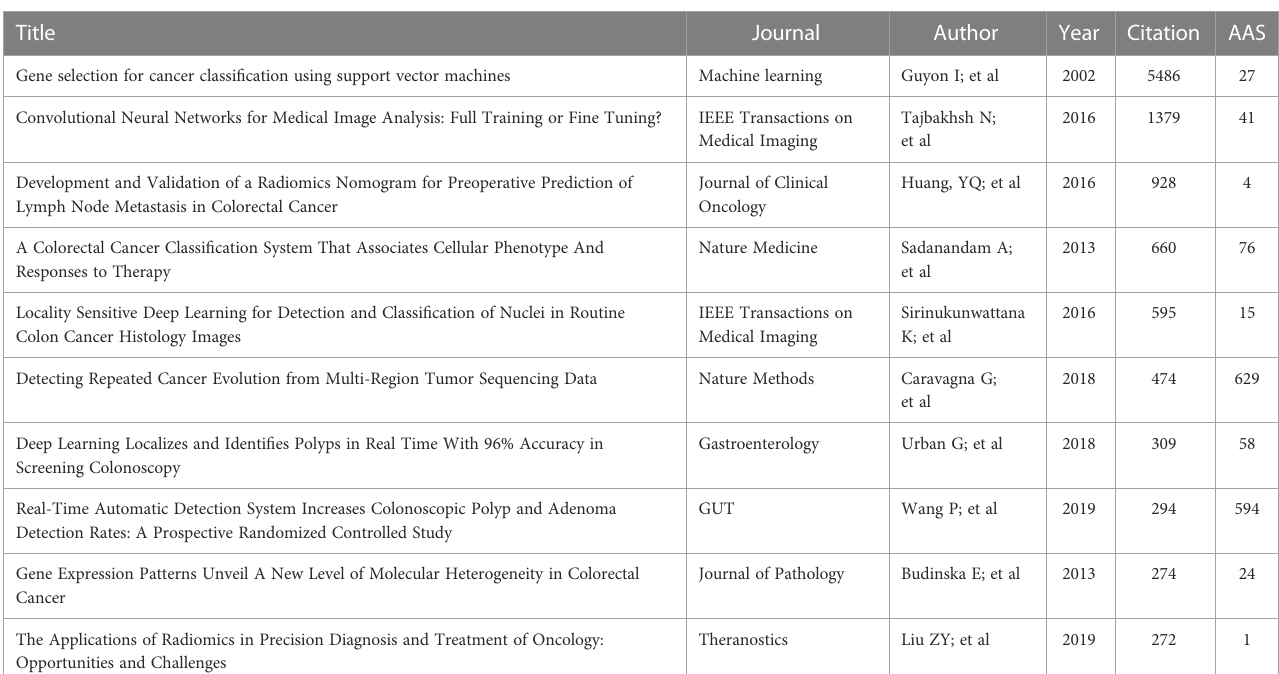
TABLE 5 Top 10 most cited